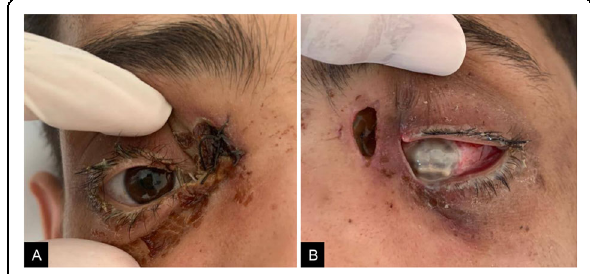
Fig. 4 Clinical photographies 12 days after initial presentation showing bilateral extensive eyelid necrosis with purulent melting of the left